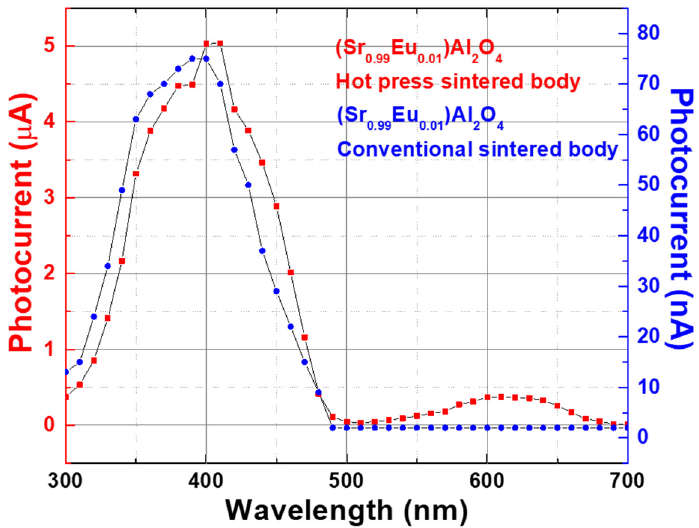
Figure 5. Changes in photocurrent as a function of the wavelength of the conventionally sintered body and hot-press-sintered body samples for 2-h sintering at 1400 °C.